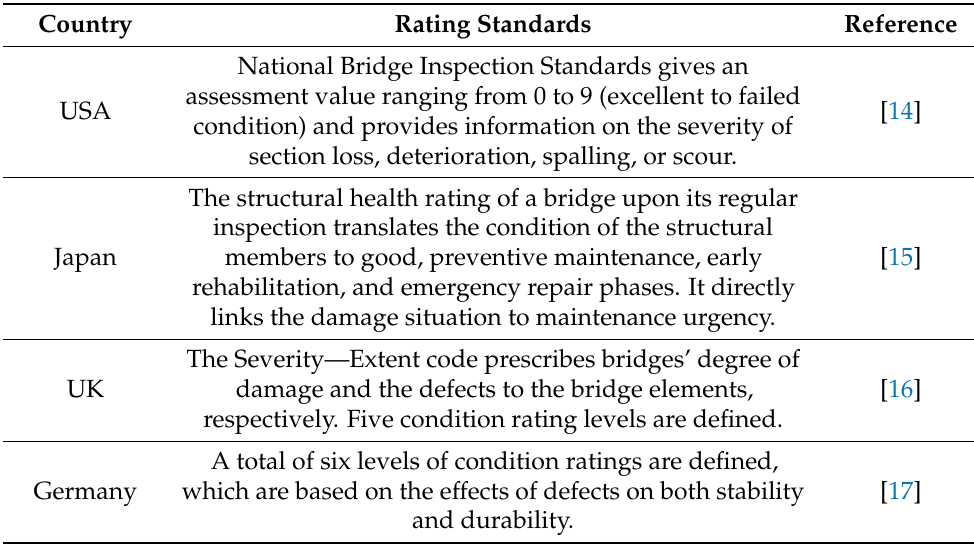
Table 1. Examples of condition rating standards.